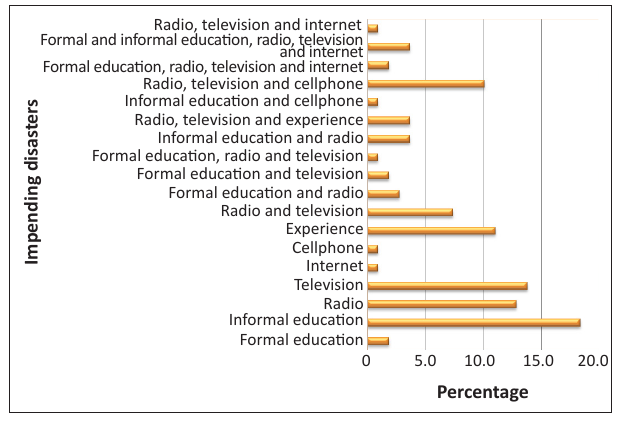
FIGURE 6: How knowledge on impending disasters is gained.